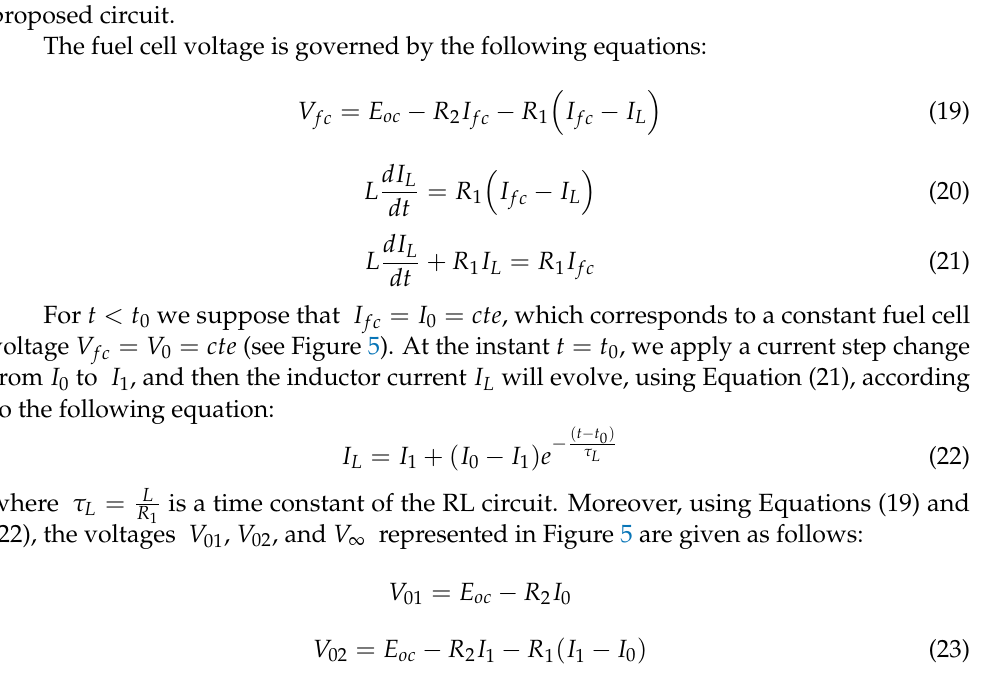
Figure 6. Equivalent electric RL circuit of a fuel cell stack.